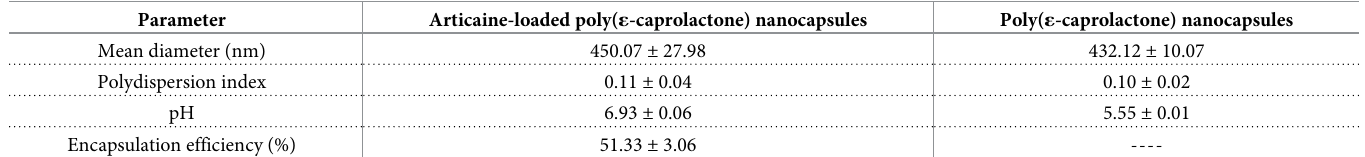
Table 1. Mean diameter, polydispersion index, encapsulation efficiency, and pH values obtained for the poly( ε -caprolactone) nanocapsules.